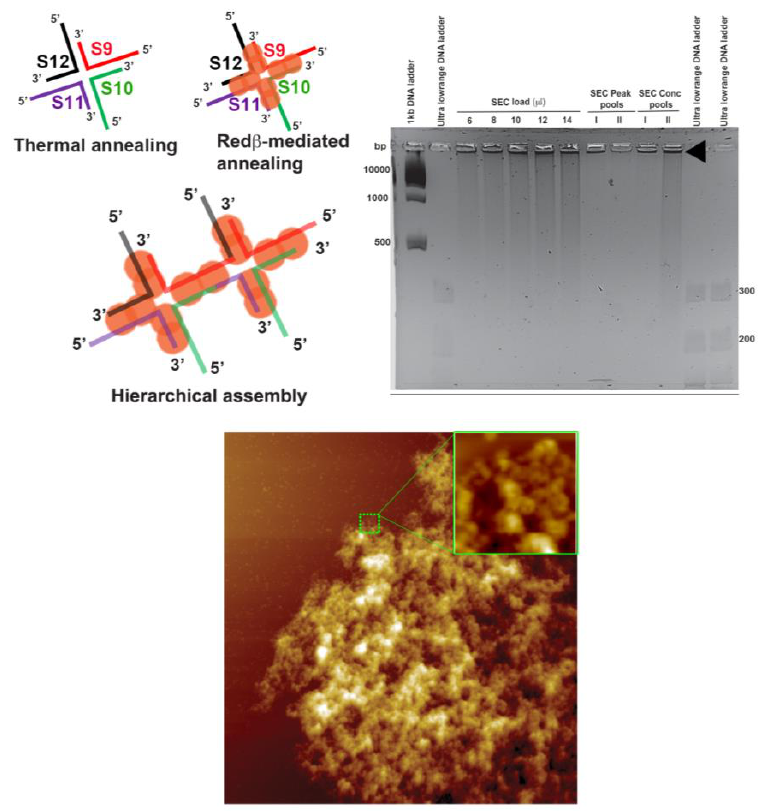
Figure 8. The schematic structures show the design and hierarchical assembly of a 66 mer HJ structure in which each arm has complementary sticky end sequences for hierarchical assembly. The sodium borate agarose gel analysis shows that the assembled structures are too large to enter the gel (indicated by the black arrowhead). The AFM image of the concentrated Peak I shows the efficient Redβ-assisted hierarchical assembly of the 66 mer HJ structures. A zoomed section in the AFM image depicts the microstructures present inside the hierarchical structure. The AFM image has a size of 5 × 5 µm 2 and a height scale of 20 nm.